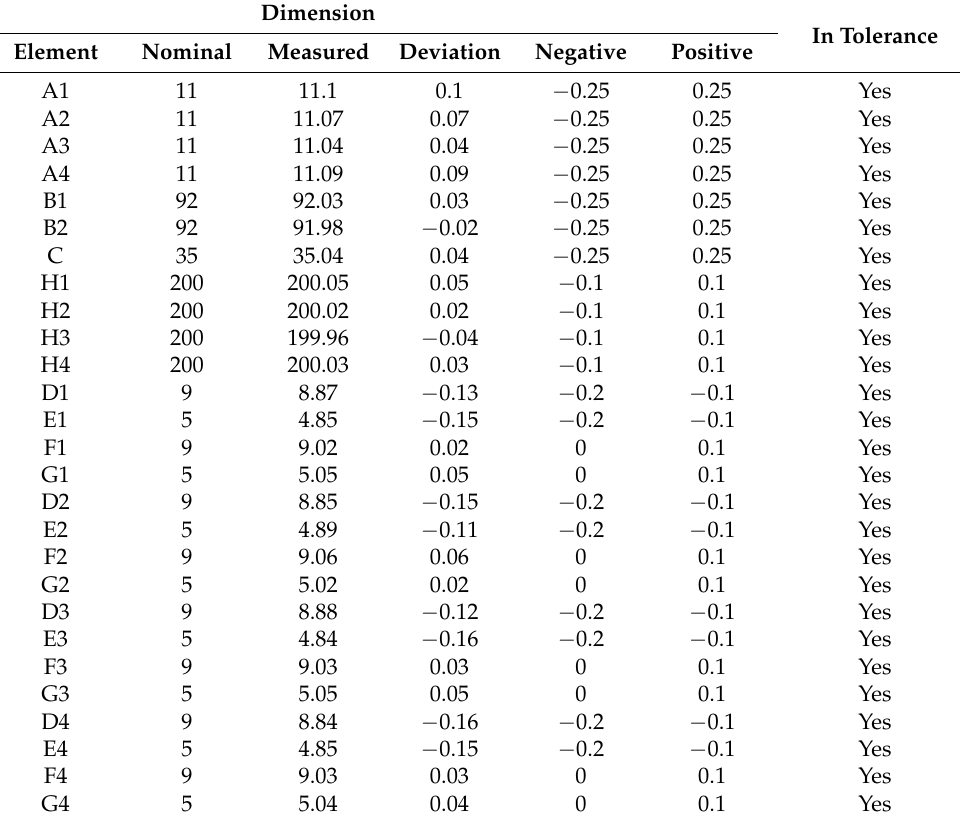
Table 8. Dimensional verification of fabricated components.